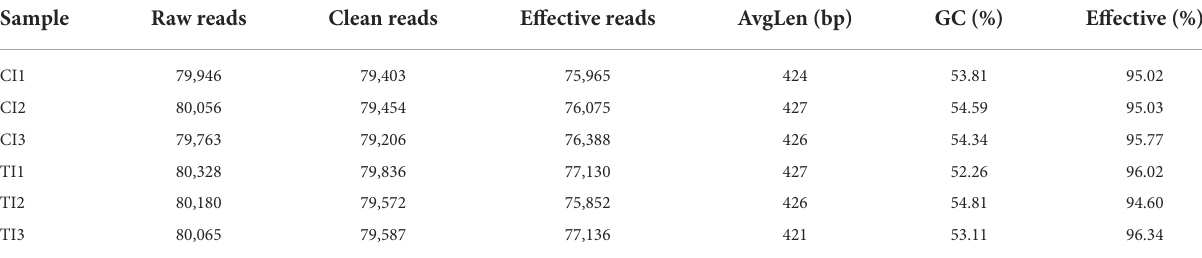
TABLE 1 Sequence data of each